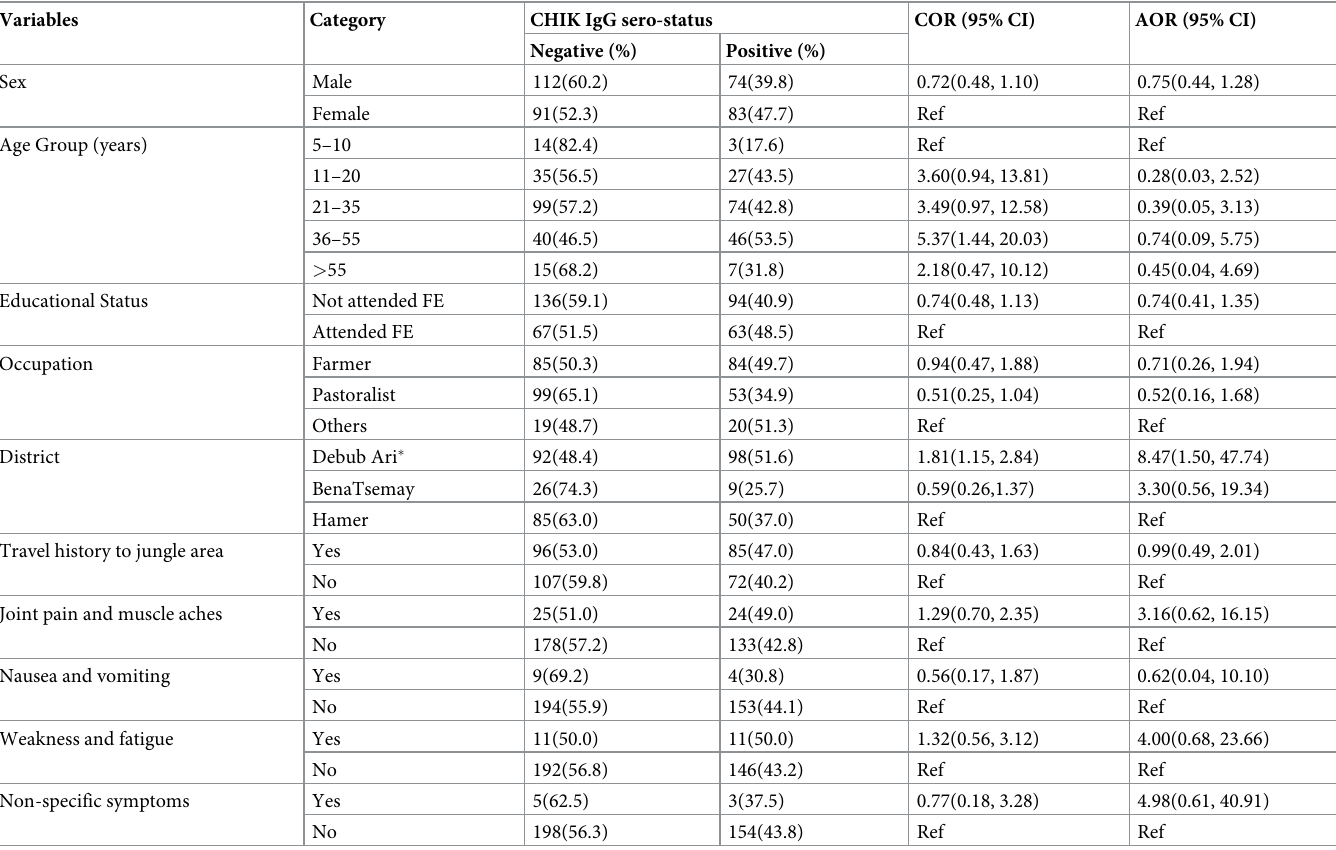
Table 3. Sero-positivity for IgG antibody to CHIKV and associated factors in the study participants (N = 360).